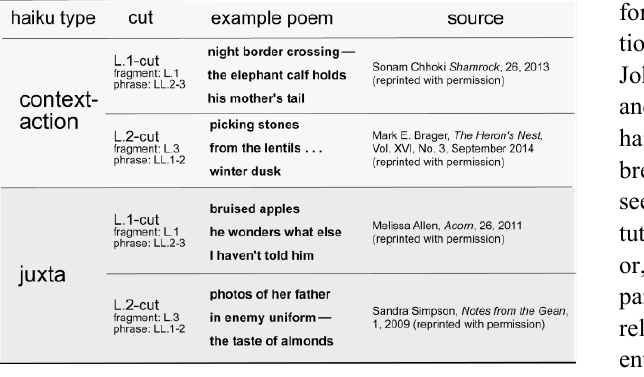
Figure 1. Stimulus material. Example haiku from the sample used in the study, for each of the four haiku type x cut position conditions. As an illustration of the interplay between the BG–FG modes of processing in haiku reading, take, for example, S. Chhoki's poem: the fragment “night border crossing” in this haiku will invoke, in the reader's mind, a grounding context/situation model, setting up expectations as to the range of possibilities to follow depending on personal, cultural, and/or other associations, most likely involving humans/the narrator crossing a border clandestinely, invoking feelings of danger, worry, suspense. The subsequent phrase (following an explicit cut marker) “the elephant calf / holds his mother's tail” will challenge this situation model, jolting the reader into foreground mode. In this mode, the reader can adapt/change the model from ‘human’ to ‘animal’ agents, though effecting this adaptation/ change is compounded by the realization that animals do not know anything about human-defined borders. The final line then adds an element (that is shared by humans) of touch/touching/feeling of security/containment, as well as reso- lution, which is put against the suspense set up in the first